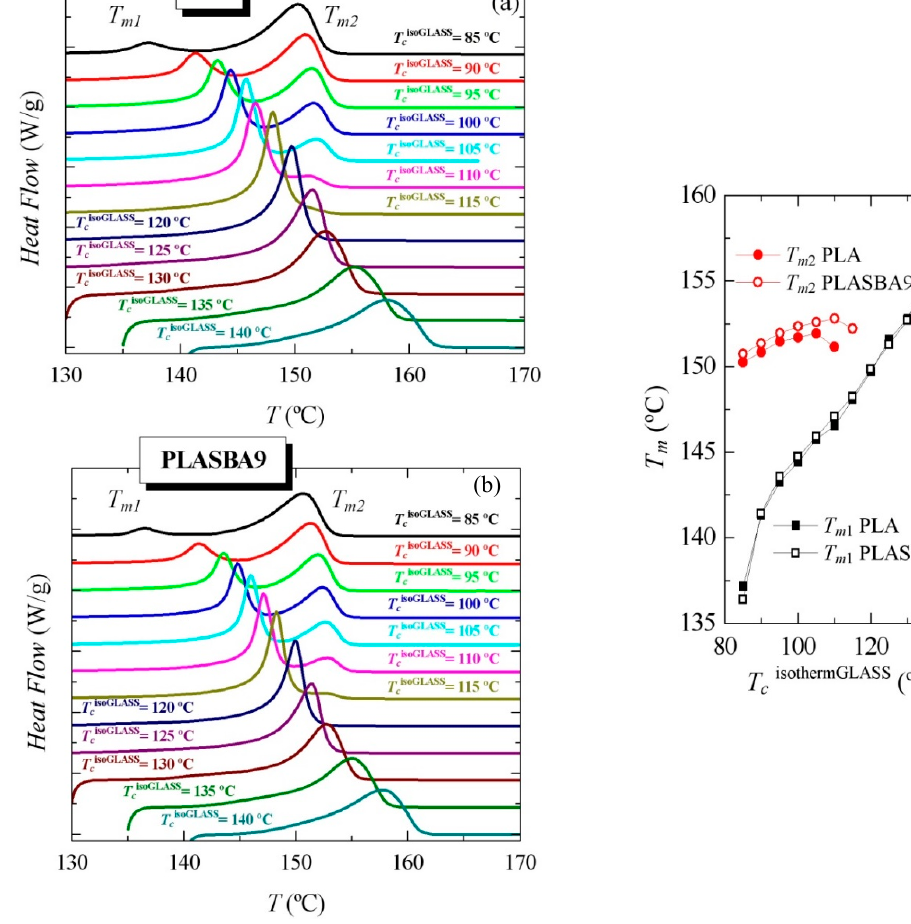
Figure 9. Effect of isothermal crystallization temperature from the glass, T c isothermGLASS , on the melting behavior for ( a ) neat PLA and ( b ) its composite PLA-SBA9. ( c ) Dependence of melting temperatures on T c isothermGLASS .